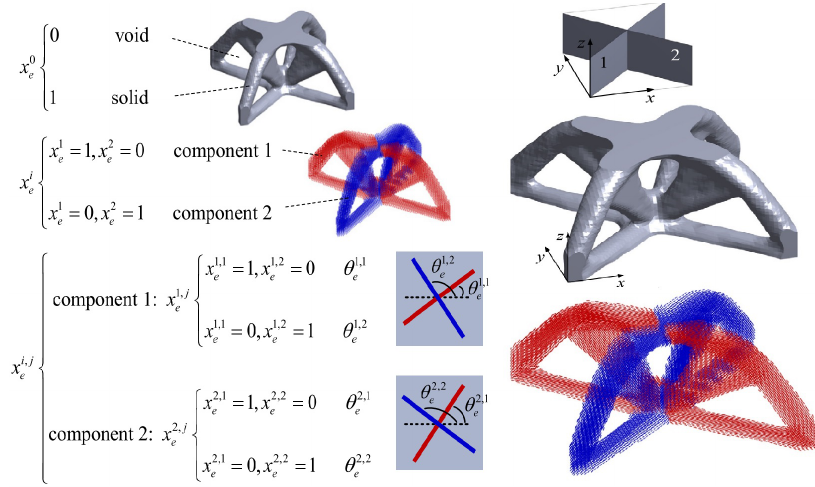
Figure 4. ( Left ) Schematic diagram represents design variables of an element and parameterizing continuous orientation variable in the discrete-continuous setting. ( Right ) Implementation of the multiple print plane to design MBB